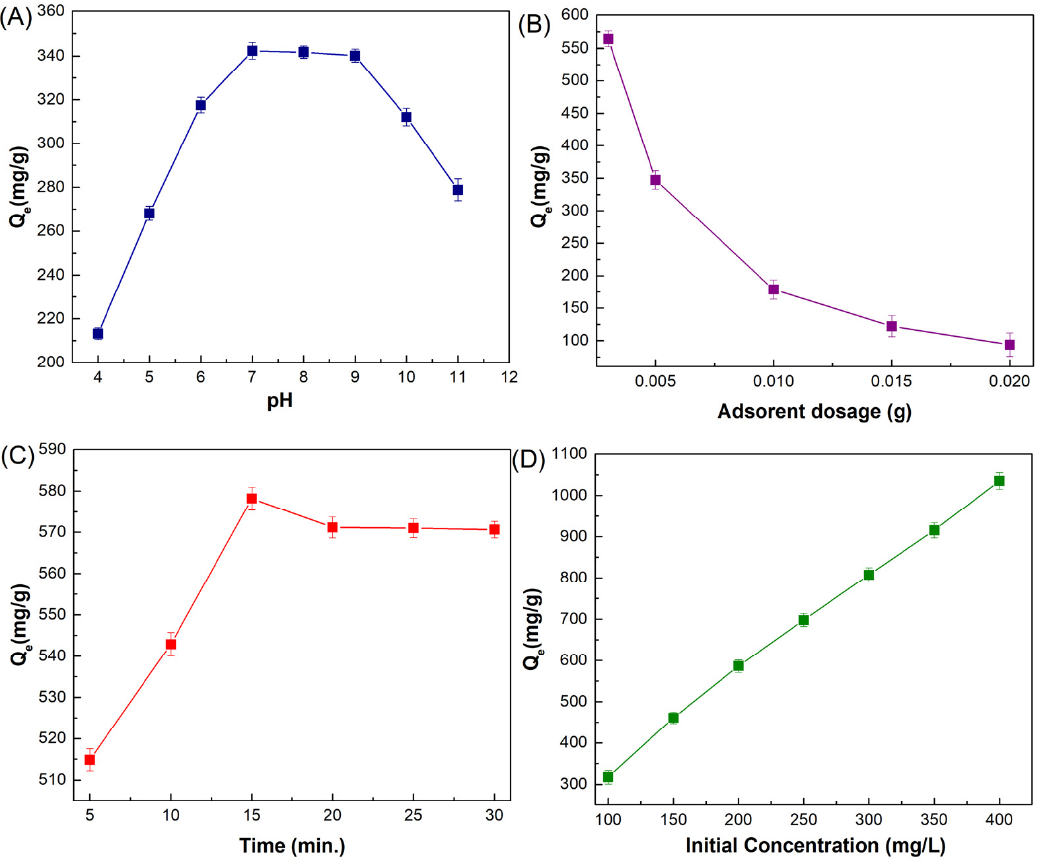
Figure 7. ( A ) Effect of solution pH (4–11) on adsorption capacity (mg/g) [MMIP dosage (5 mg), ciprofloxacin initial concentration (200 mg/L), V (0.01 L), Time (30 min), T (298 K)], ( B ) MMIP dosage (3–20 mg) on adsorption capacity (mg/g) [pH 7, ciprofloxacin initial concentration (200 mg/L), V